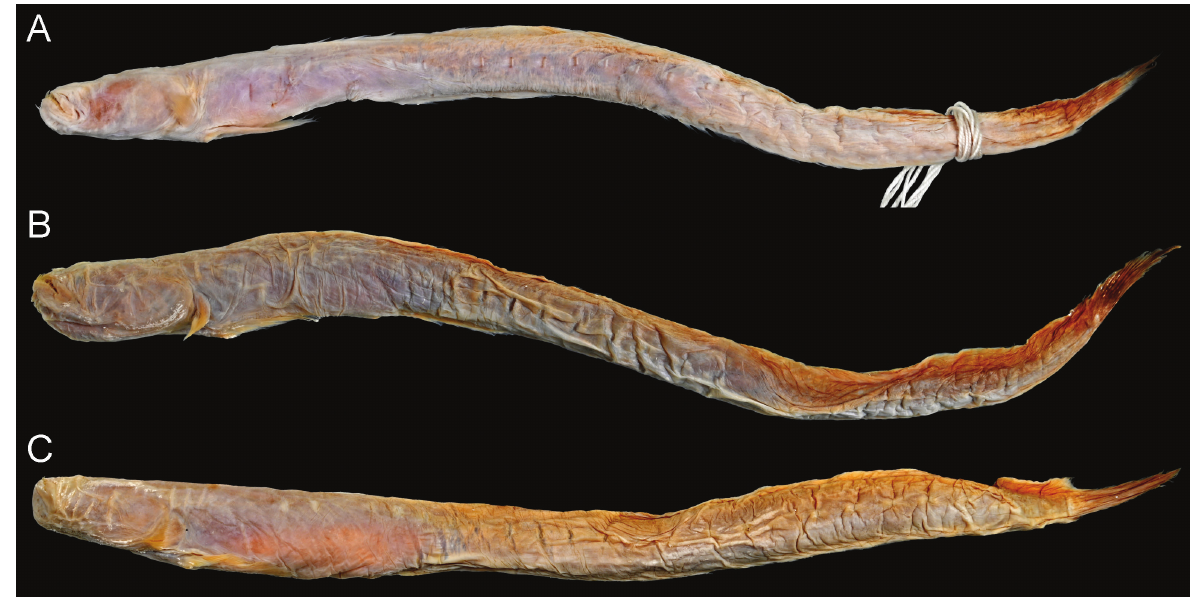
Figure 1. Preserved specimens of Taenioides snyderi from Taiwan. A : NMMB-P5491, male, 150.7 mm SL, Chiayi; B : one of NMMB-P32256, male, 156.8 mm SL, Zengwen River; C : one of NMMB-P32256, female, 160.9 mm SL, Zengwen